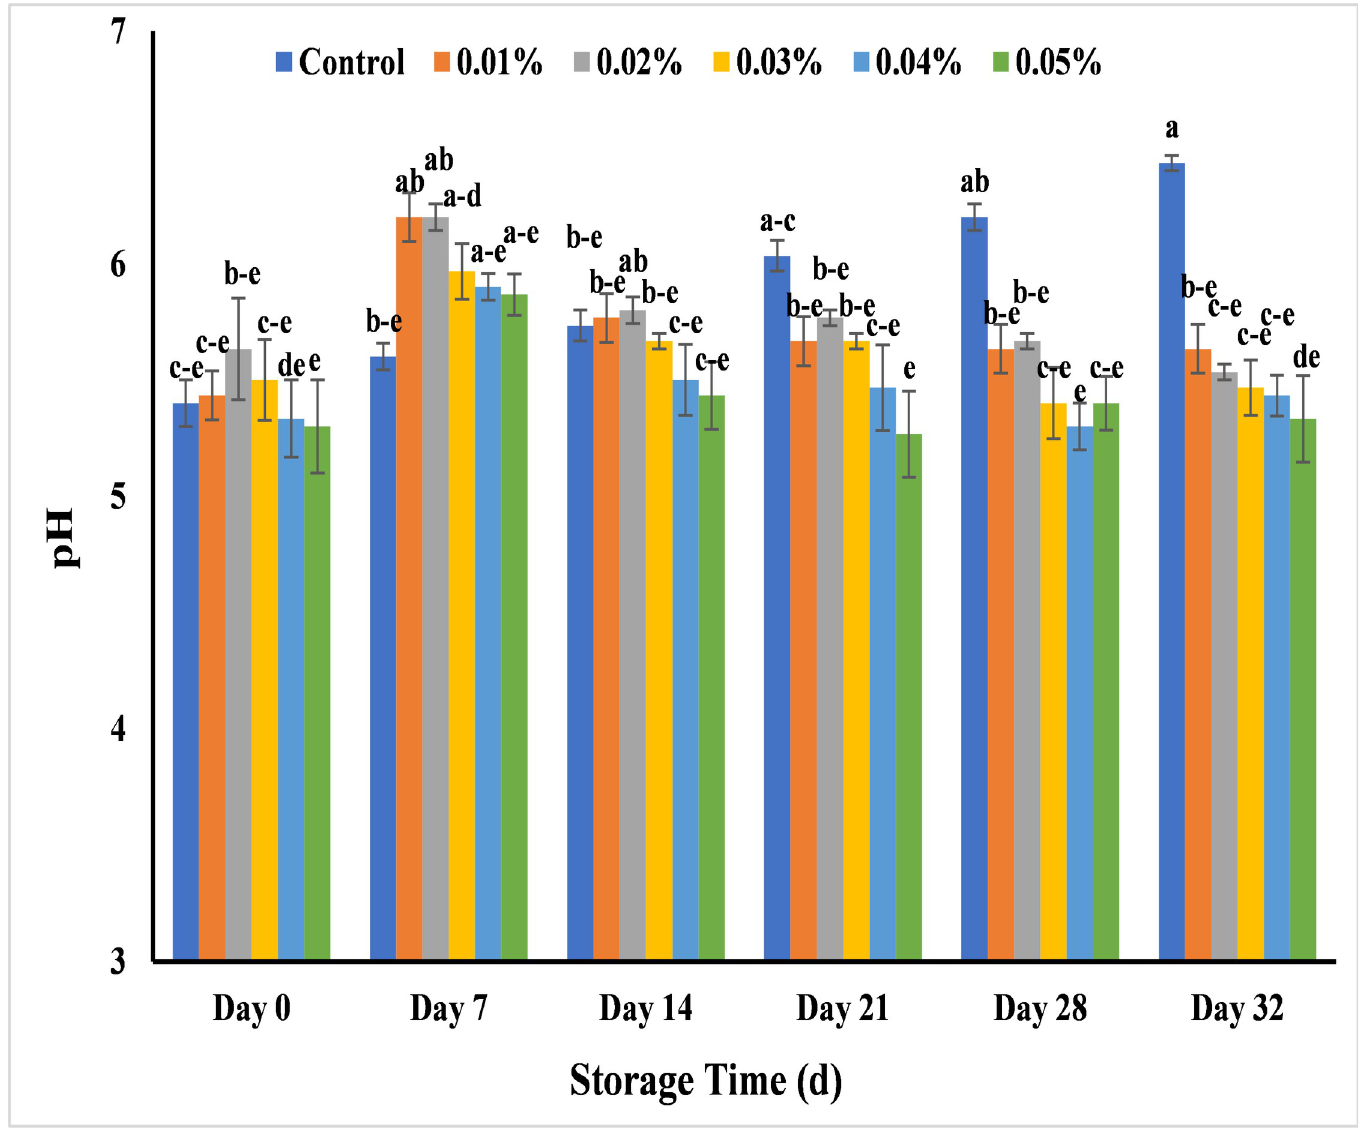
Fig 16. Effect of AgNPs concentrations (T0 = control, T1 = 0.01%, T2 = 0.02%, T3 = 0.03%, T4 = 0.04%, T5 = 0.05%) on pH of Cavendish banana (BASRAI) during 32 days of storage.